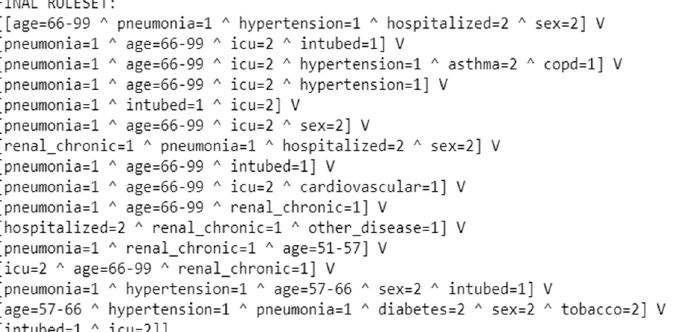
Figure 3. Rule set extracted using RIPPER to classify mortality in COVID-19